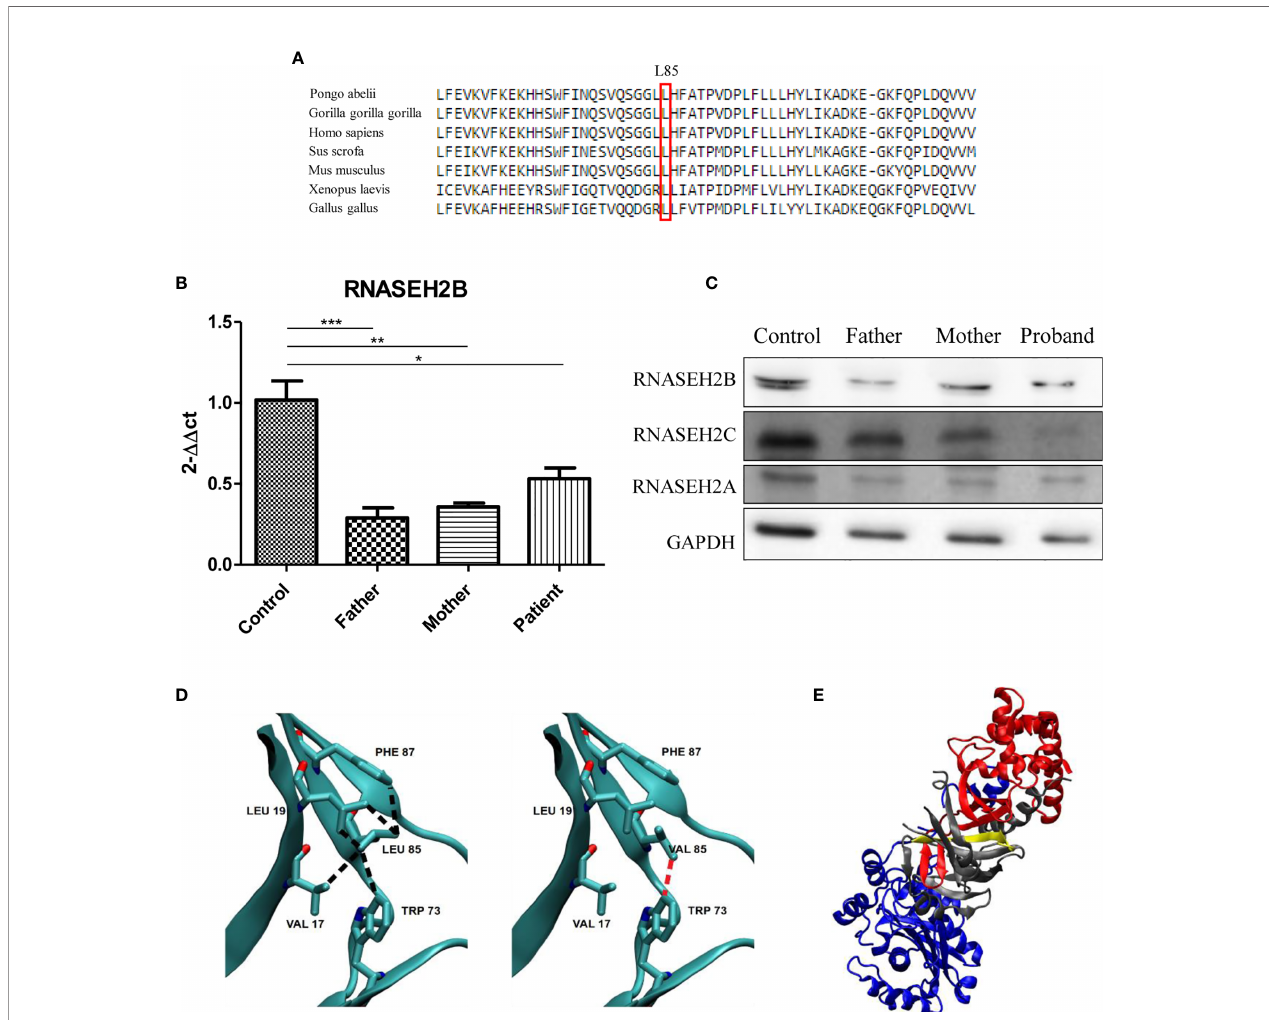
FIGURE 2 | Characterization of the two RNASEH2B mutations. (A) The L85 residue of RNASEH2B is evolutionarily conserved crossing all examined species. The conserved Leucine residue is shown in the rectangular box. Protein sequences were obtained from the National Center for Biotechnology (NCBI). (B) Expression levels of RNASEH2B transcripts in a healthy control, parents, and proband * P < 0.05, ** P < 0.01, *** P < 0.001. (C) Western blot analysis of RNase H2B, RNase H2C, and RNase H2A protein levels in a healthy control, parents, and proband. GAPDH has been used as loading control. (D) The contacts involving amino acid L85 with V17, L19, W73, and F87 on the native (left panel, black broken lines) and L85V mutant (right panel, red broken lines) of RNASEH2B . (E) The crystal structure of RNASE H2 complex with RNASEH2A, RNASEH2B , RNASEH2C highlighted in blue, red and gray, respectively. On the same fi gure the fi rst 30 residues of RNASEH2B (of which 1 – 12 are missing in the crystallographic structure) are highlighted in